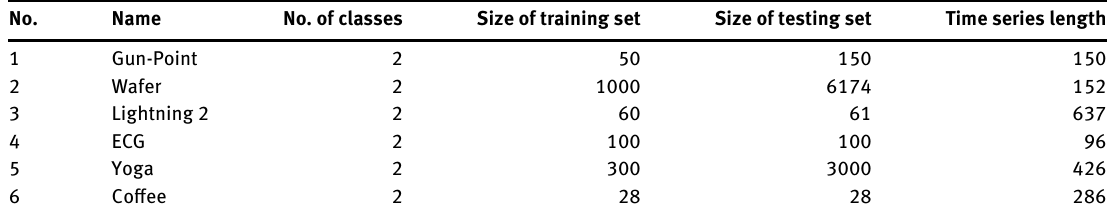
Table 1: Characteristics of Datasets.